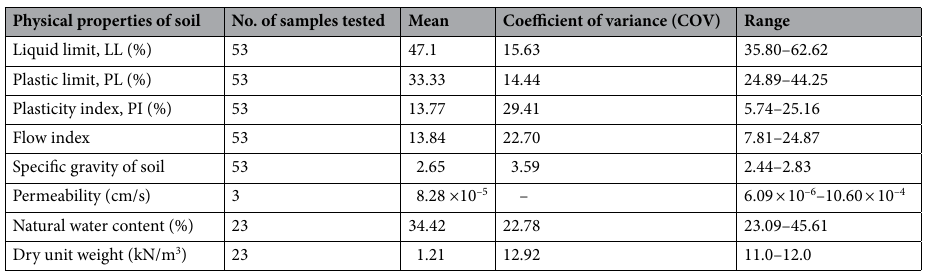
Table 1. Index properties of the